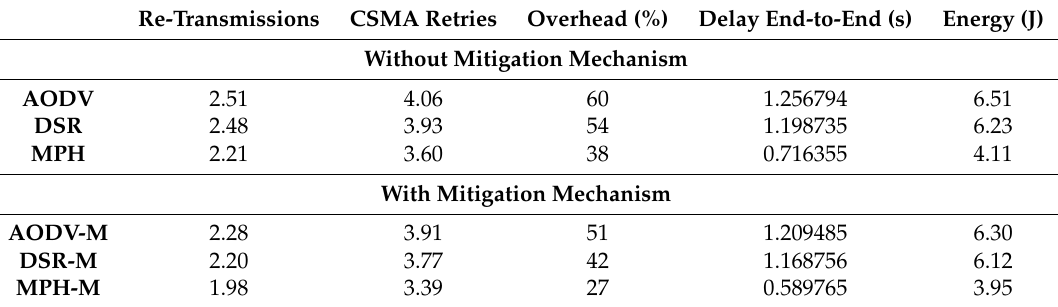
Table 5. Performance metrics per node under an uniform random traffic rate generation.